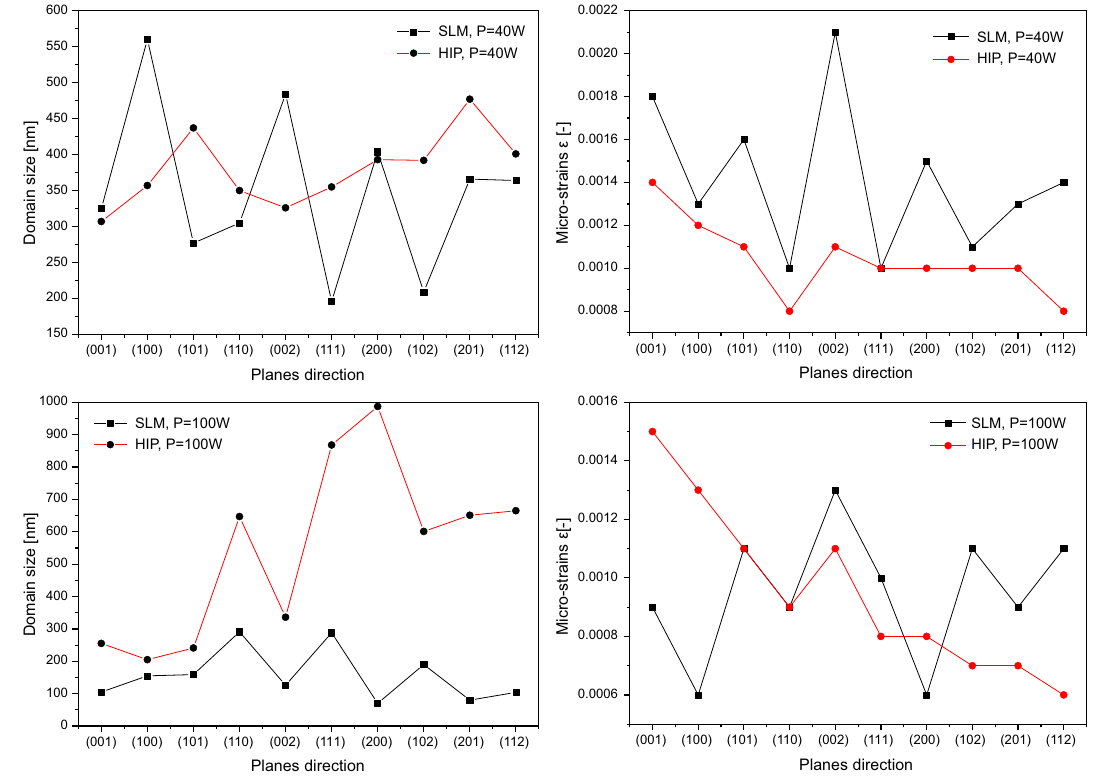
Figure 13. Comparison between α -phase crystallite size and micro-strains after SLM in specimens prepared at low VED (P = 40 W) and high VED (P = 100 W) and their changes induced by the subsequent HIP.